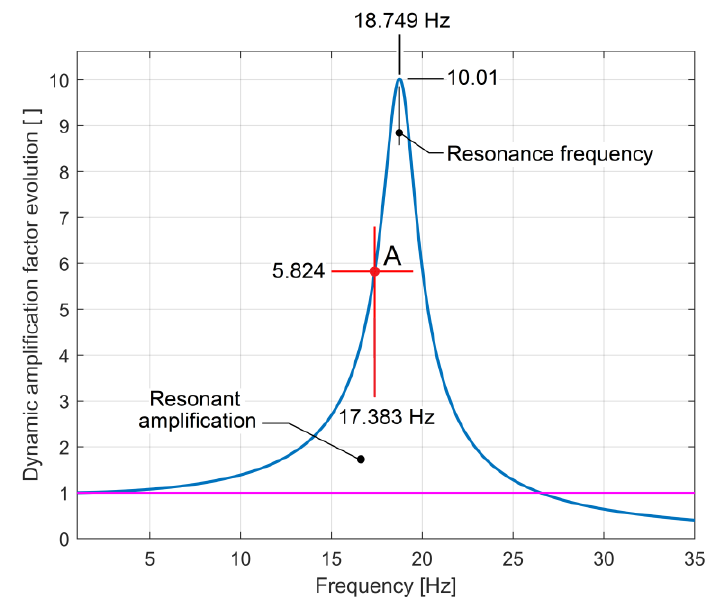
Figure 18. The evolution of the dynamic amplification factor D af generated by the headstock foundation in the resonance area, based on Equation (10) and experimental free damped response analysis.